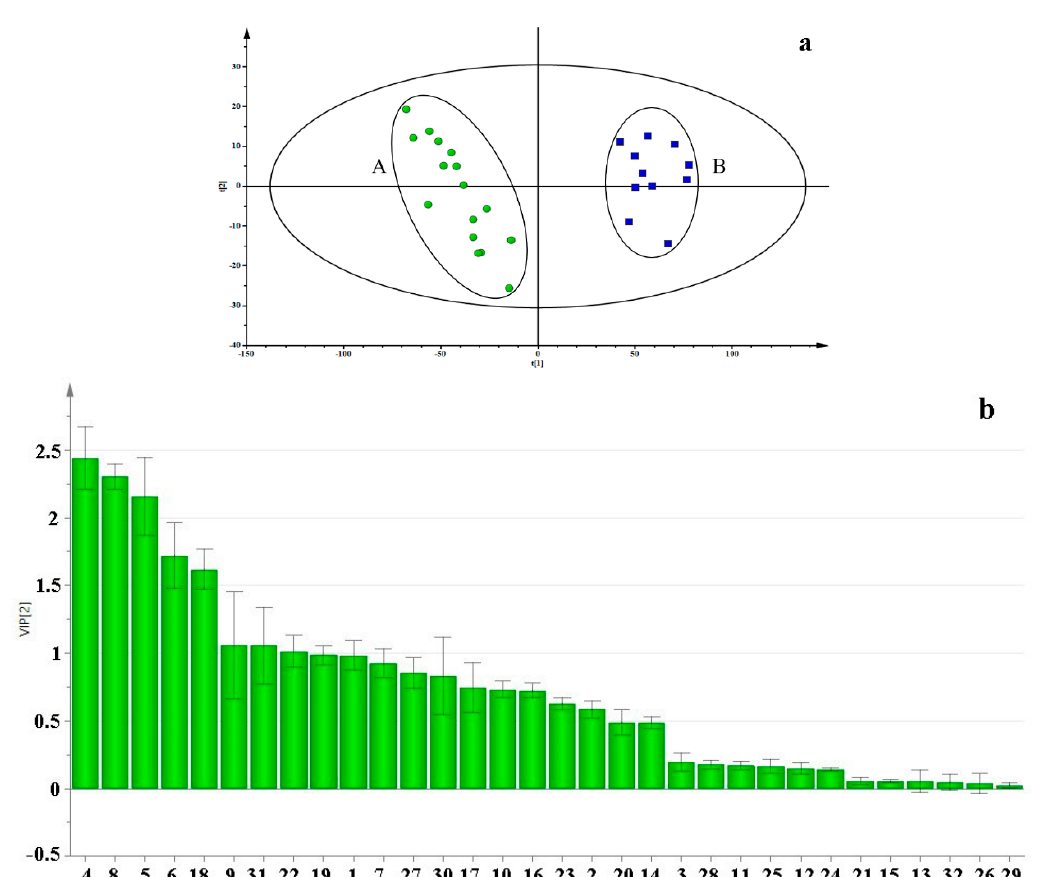
Figure 4. The partial least squares discriminant analysis (PLS-DA) score scatter plot ( a ) and variable importance in the projection (VIP) ( b ) of Chuan maidong (CMD) ( A ) and Zhe maidong (ZMD) ( B ).